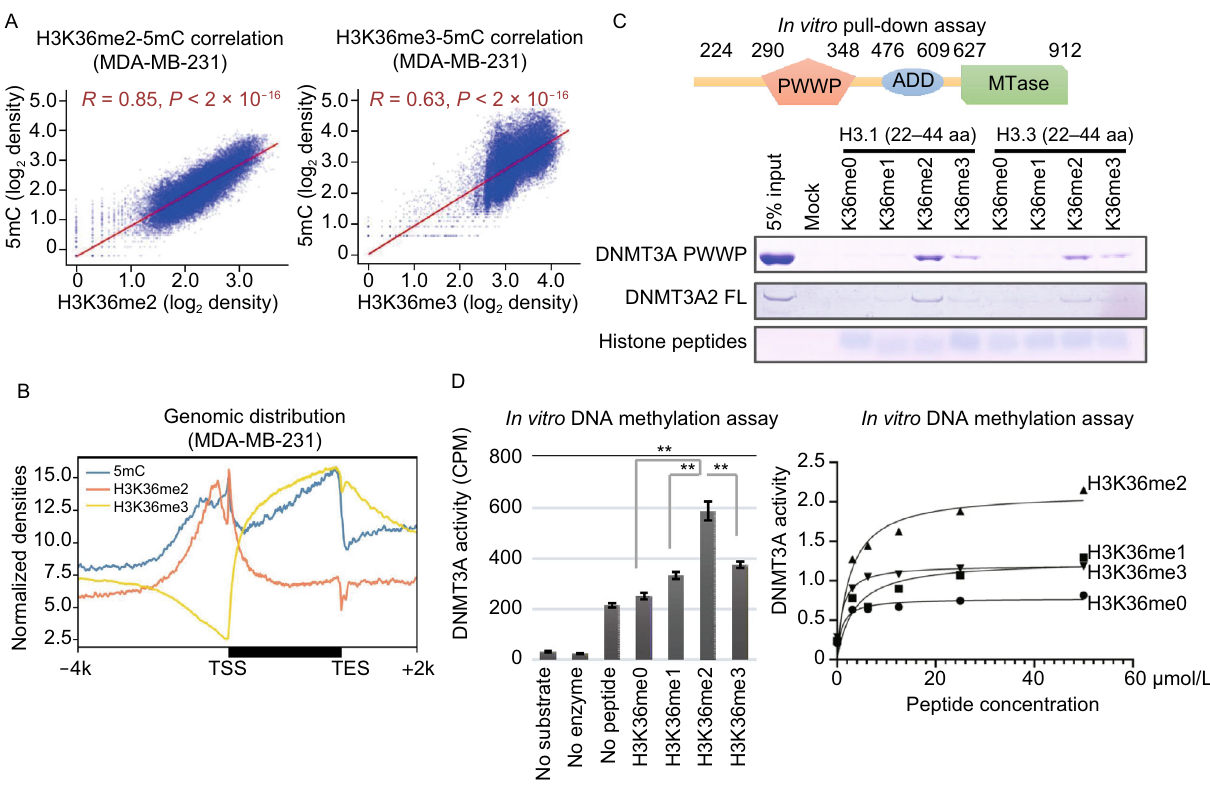
Figure 1. Genome-wide correlation between DNA 5mC and H3K36me2 and DNMT3A preferentially binds and is activated by H3K36me2 . (A) Scatterplots showing genome-wide correlation between H3K36me2 and 5mC (left), and H3K36me3 and 5mC (right) in MDA-MB-231 cell. The number of reads was counted in nonoverlapping 100-kb bins spanning the human genome. The correlation coef fi cient was calculated with Pearson correlation. (B) Aggregation plot showing the distribution patterns of 5mC, H3K36me2 and H3K36me3 in the indicated genomic regions. (C) Schema of DNMT3A2 domain architecture and biotinylated peptide pull-down assay of DNMT3A2 FL and PWWP domain with the indicated histone H3.1K36 and H3.3K36 peptides. (D) In vitro DNA methylation assay testing the stimulation of DNMT3A activity with the indicated histone peptides (H3.1 22-44aa) (** P value < 0.01) (left, radioactivity), and at different concentrations (right, Michaelis-Menten graph analyses, MBD2b